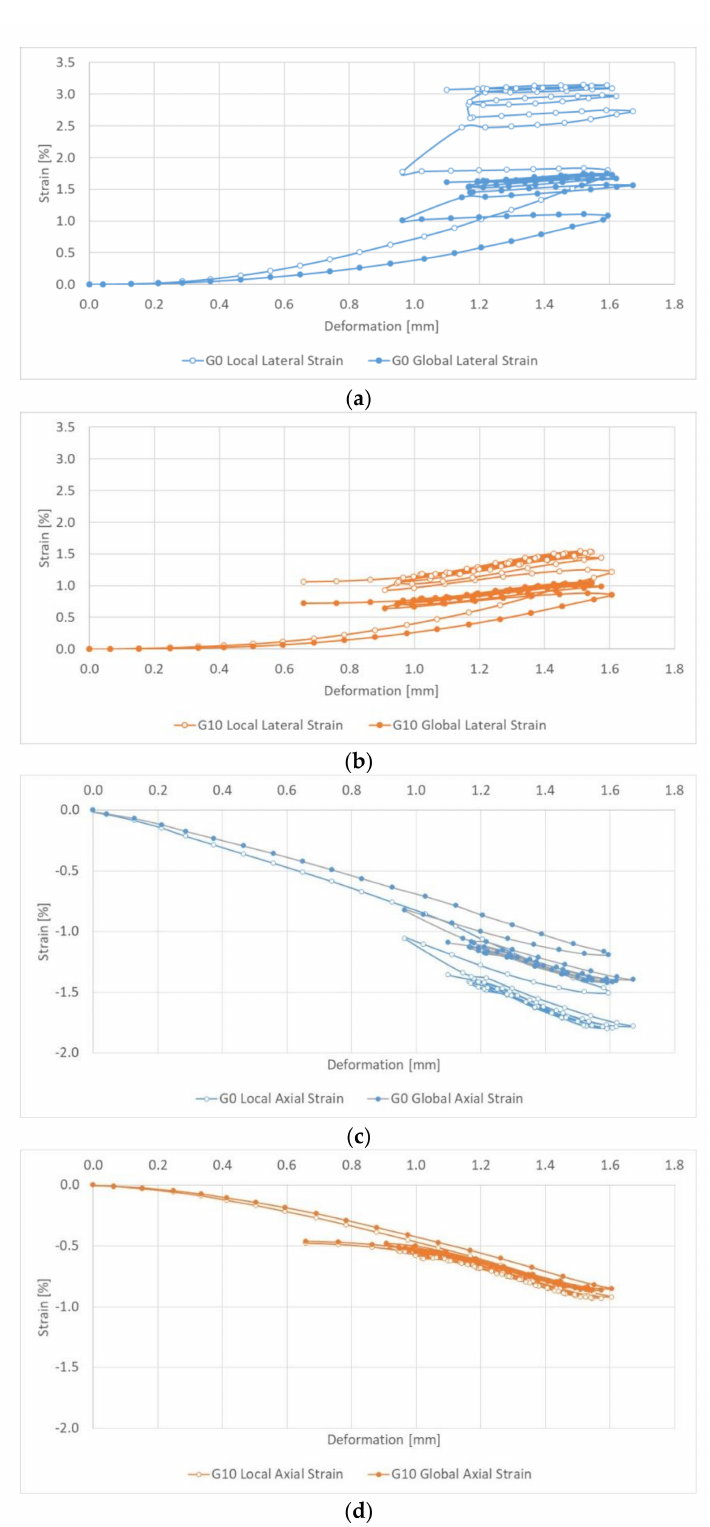
Figure 15. Dependence of global and local strains on axial samples deformation: ( a ) lateral strains G0; ( b ) lateral strains G10; ( c ) axial strains G0; ( d ) axial strains